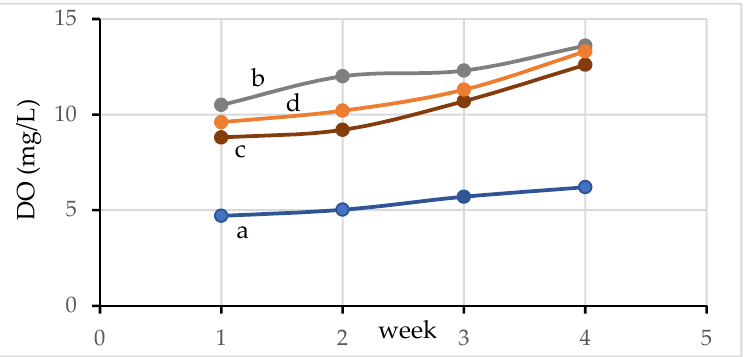
Figure 8. DO values of the water of ( a ) pond 1 ( b ) hydroponic system without an aquaculture pond ( c ); pond 2; and ( d ) pond 3.